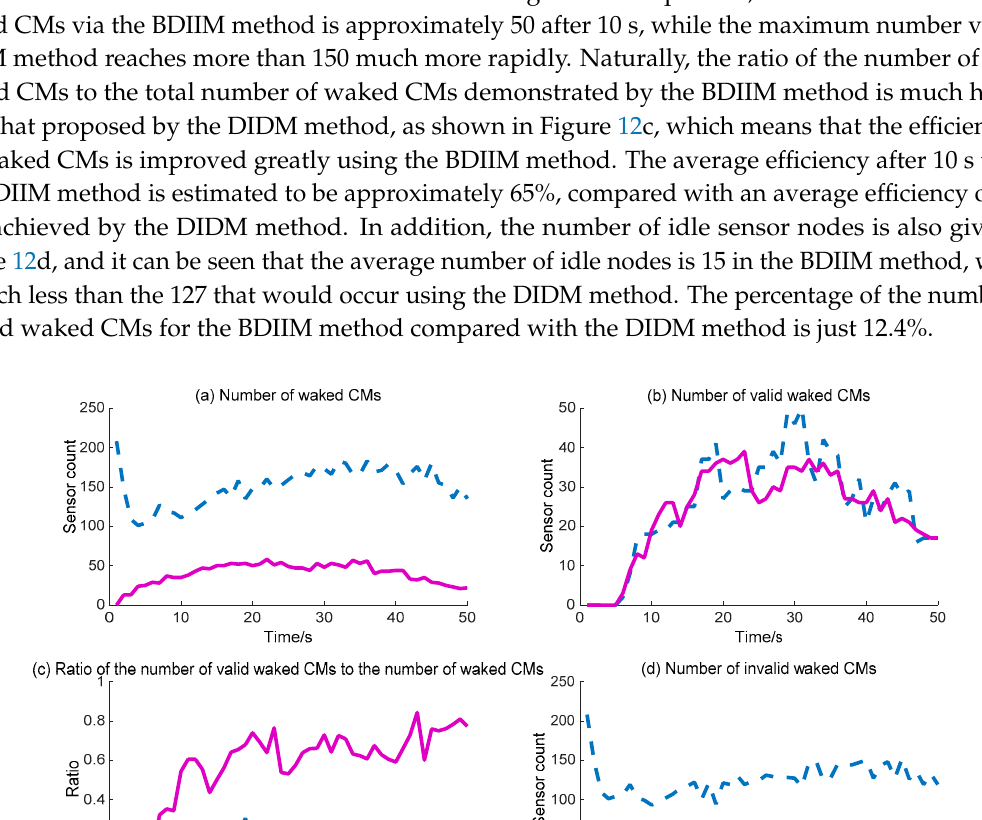
Table 6. Data of the CMs performance of nodes in WC.